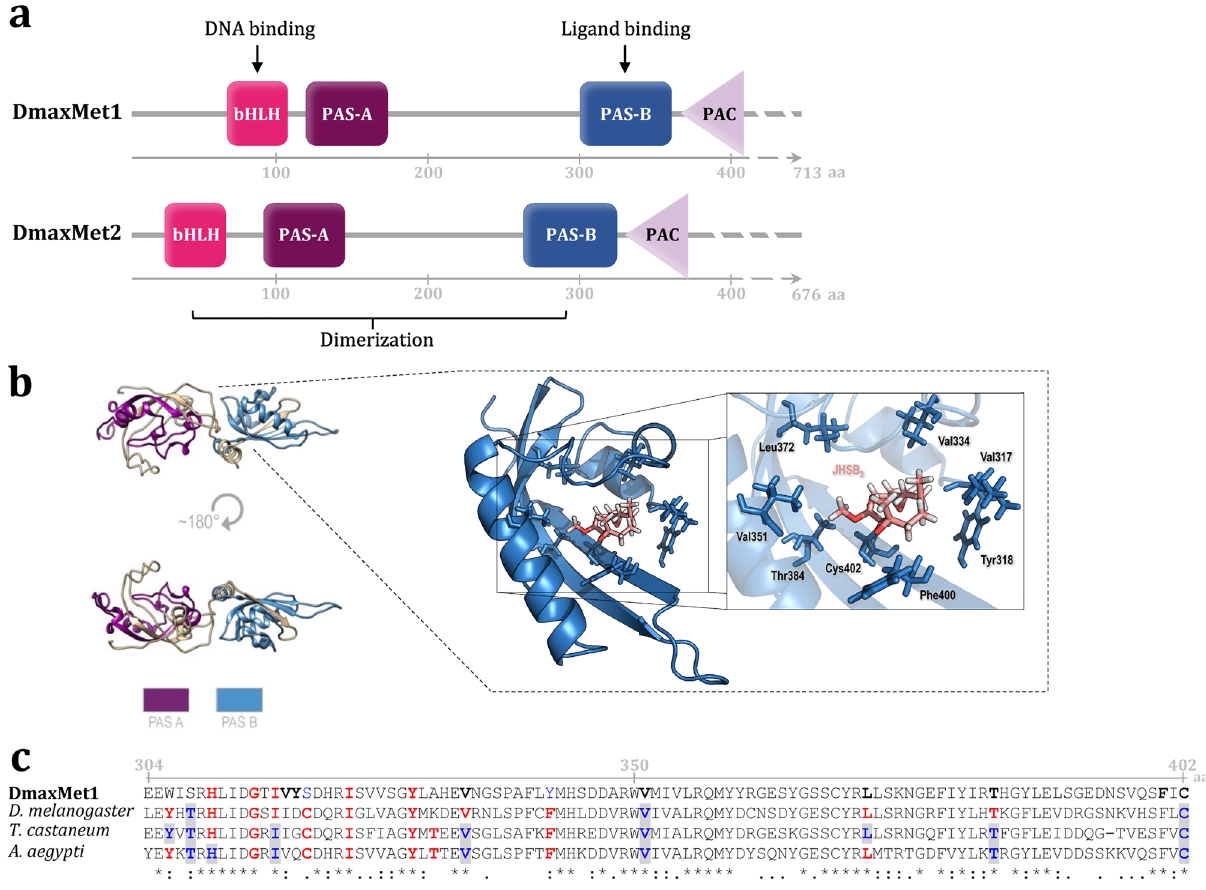
Figure 1. DmaxMet structure, modelling and docking. ( a ) Schematic view of DmaxMet1 (713 aa) and DmaxMet2 (676 aa) predicted protein sequences, showing the conserved domains, as well as DNA and ligand binding locations. ( b ) Structural model for DmaxMet1, displayed as a molecular surface superposed to a cartoon representation (left), with the detail of the in silico interactions between JHSB 3 and the PAS-B domain of DmaxMet1 (right). ( c ) Alignment of DmaxMet1 PAS-B-PAC domains and D. melanogaster Met (NP_001285132.1), T. castaneum Met (NP_001092812.1), and A. aegypti Met (AAX55681.1), showing amino acid (aa) residues involved in JH-Met interactions. Gray line: amino acids (aa) position of DmaxMet; black bolded amino acids: aa affecting JH binding to DmaxMet1; shaded blue amino acids: mutations that affected JH binding to D. melanogaster Met , T. castaneum Met or A. aegypti Met; red amino acids: aa identified by docking or modelling as relevant for JH